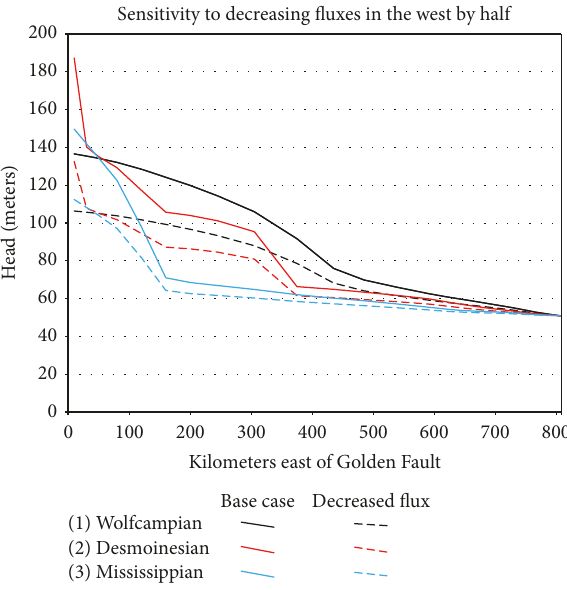
Figure 23: Sensitivity to increasing 𝐾 by half an order of magnitude in aquifers.